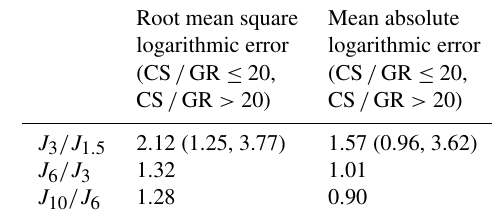
Table 2. Root mean square logarithmic error and mean absolute logarithmic error between the observed survival probabilities from 1.5 to 3nm ( J 3 /J 1 . 5 ), from 3 to 6nm ( J 6 /J 3 ), and from 6 to 10nm ( J 10 s /J 6 ) in Beijing, China and theoretical predictions based on formulation by Lehtinen et al. (2007). Root mean square Mean absolute logarithmic